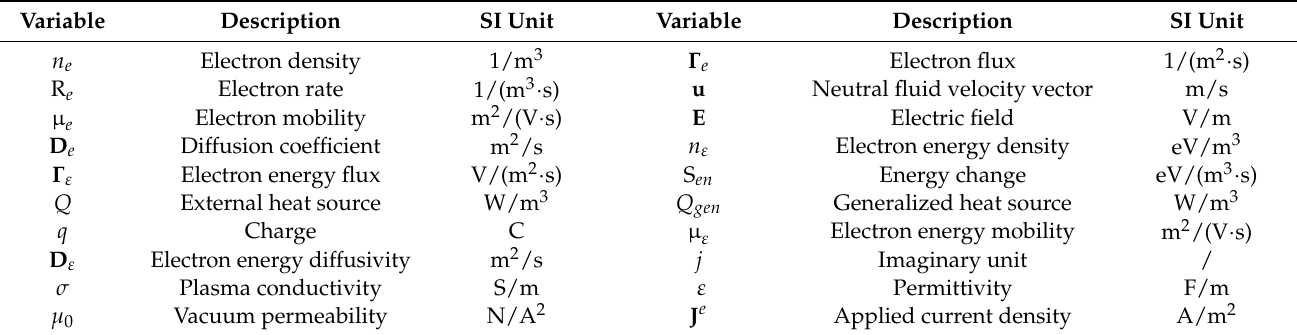
Table 2. Nomenclature used in equations in ICP